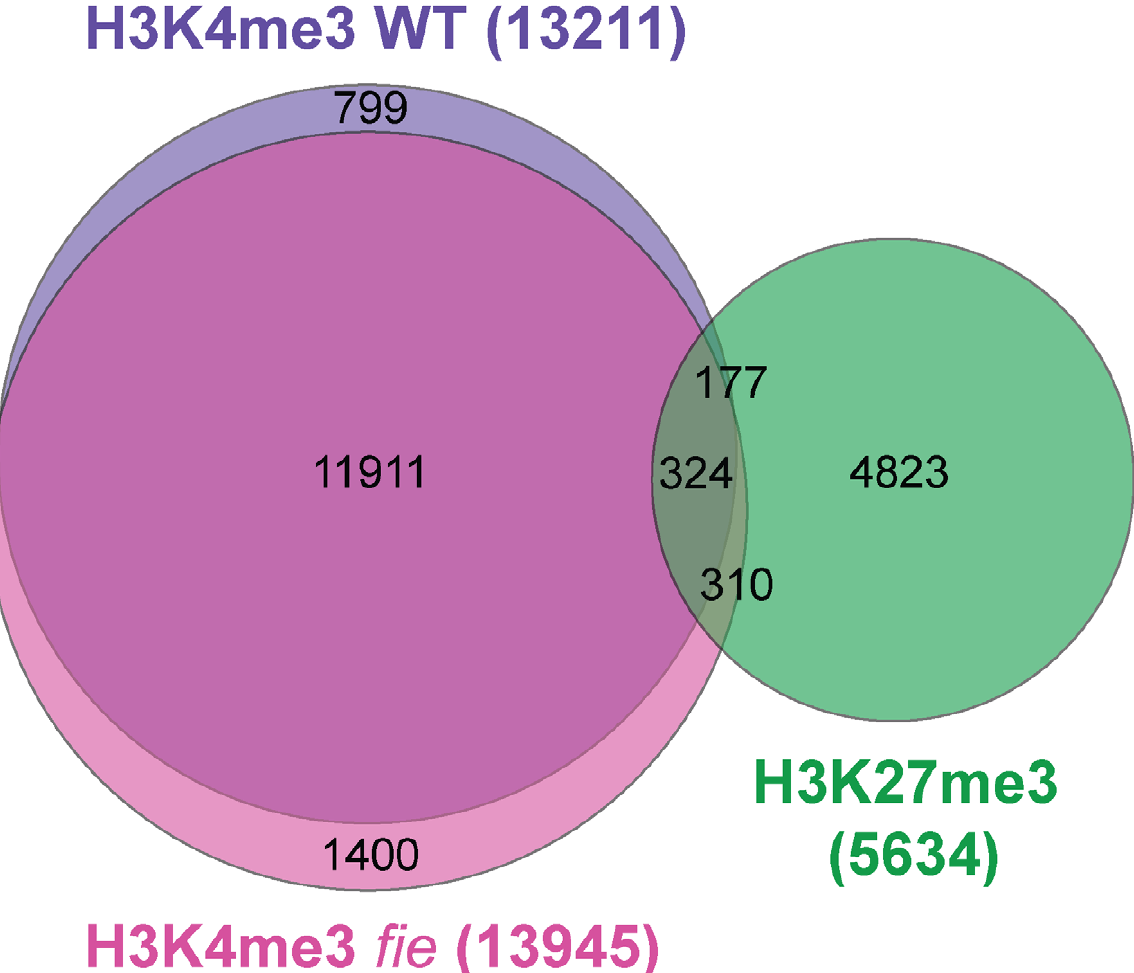
Figure 7. The set of H3K4 trimethylated genes changes only marginally between wild type and fie and is under-represented among H3K27me3 targets. VENN Diagram representing the number of genes marked by H3K27me3 in wild type (green) and H3K4me3 in wild type (purple) and fie (pink). The mutual overlap of the H3K4me3 targets in wild type and fie is larger than expected for two independent sets, while the overlap of the H3K4me3 marked genes with the H3K27me3 marked genes is significantly smaller (wild type H3K4me3 and fie H3K4me3: rf=1.9, p , 1.0e 2 99* wild type H3K4me3 and wild type H3K27me3: rf=0.2, p , 1.0e 2 99*; fie H3K4me3 and wild type H3K27me3: rf=0.2, p , 1.0e 2 99*). P-values marked by an asterisk (*) were below the calculation limits of the software (highly